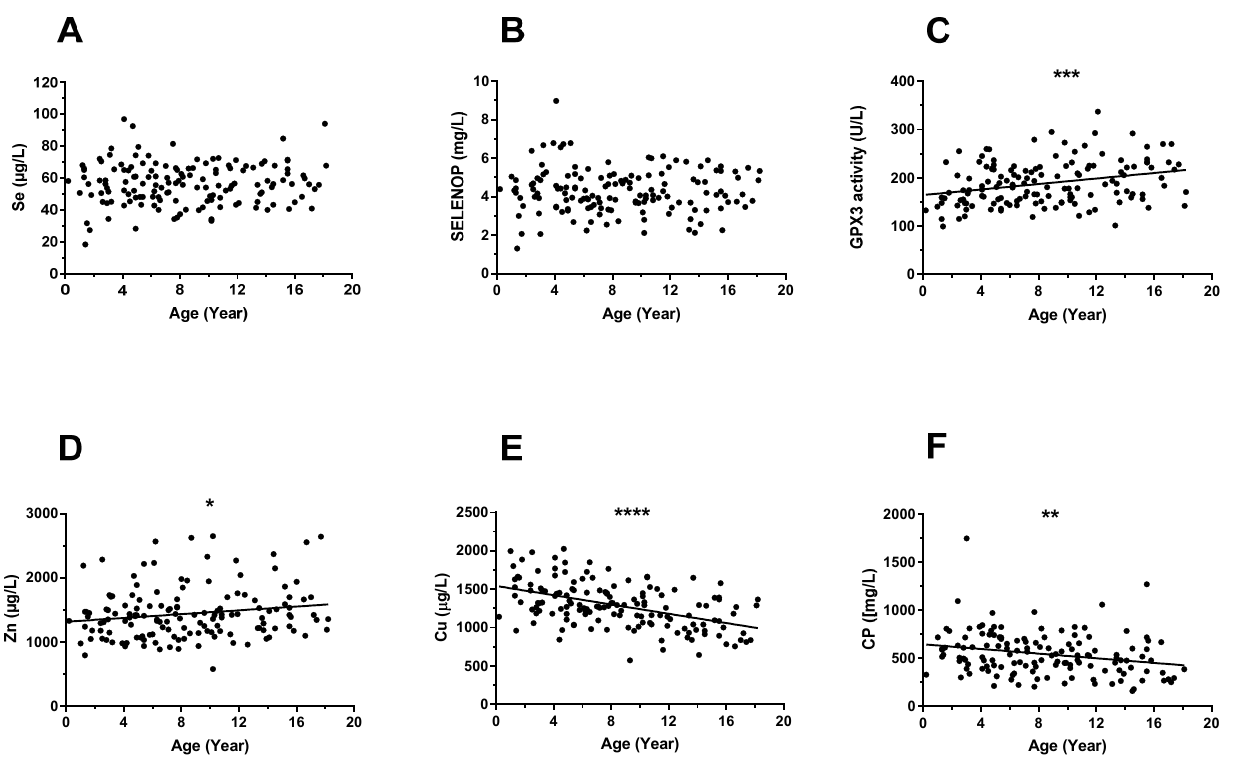
Figure 1. Correlations between age and biomarkers of trace elements in the paediatric patients. The analyses were comprising age and biomarkers of Se, Zn, and Cu status. There was no correlation between ( A ) age and serum Se, or ( B ) age and serum SELENOP concentration. Significant positive correlation was observed between ( C ) age and GPX3 activity ( r = 0.292, p = 0.0004), and ( D ) age and serum Zn concentration ( r = 0.146, p = 0.049). Strong negative correlation was observed between ( E ) age and serum Cu ( r = − 0.465, p < 0.0001) and between ( F ) age and CP concentration ( r = − 0.269, p = 0.002), indicating a declining Cu status with age. Correlation coefficients were calculated by Spearman test. Significant correlations are indicated by p -values; **** indicates p < 0.0001, *** indicates p < 0.001, ** indicates p < 0.01, and * indicates p < 0.05. SELENOP, selenoprotein P; GPX3, plasma glutathione peroxidase; CP, ceruloplasmin; Se, selenium; Zn, zinc; Cu,